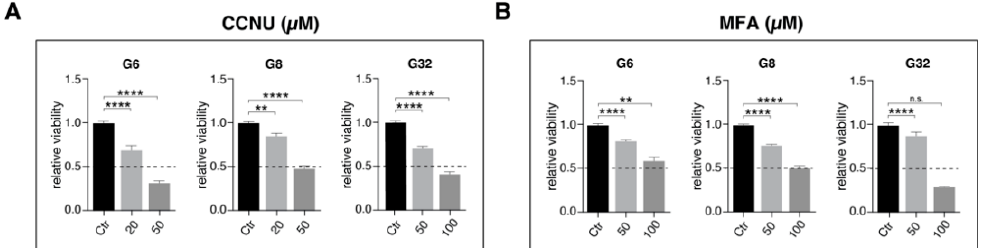
Figure 3. Relative cell viability after treatment for 144 h of the G6, G8, and G32 cell populations with ( A ) CCNU and ( B ) MFA using a MTT assay. Mean ± SEM is depicted. ** and **** denote p < 0.01 and p < 0.0001. CCNU, lomustine; MFA, meclofenamate.